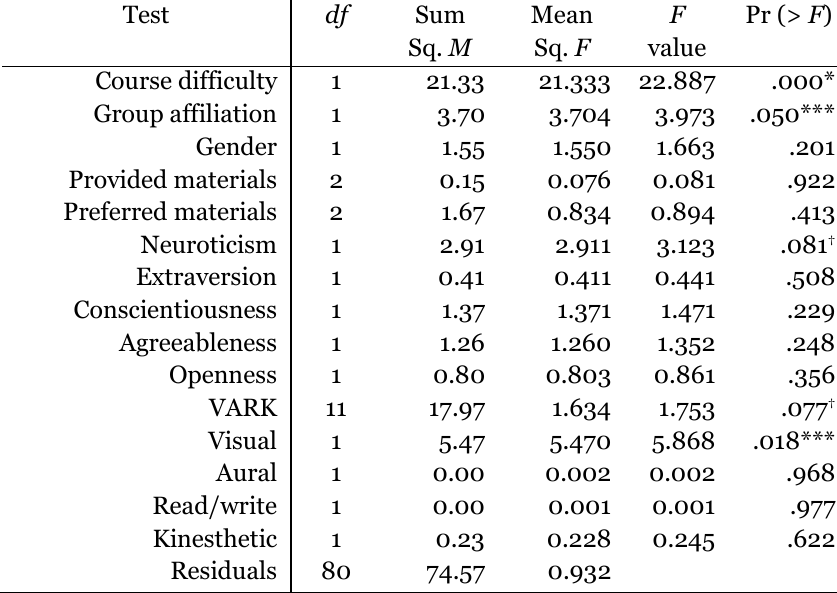
ANOVA Analysis for Test Results in Online Courses